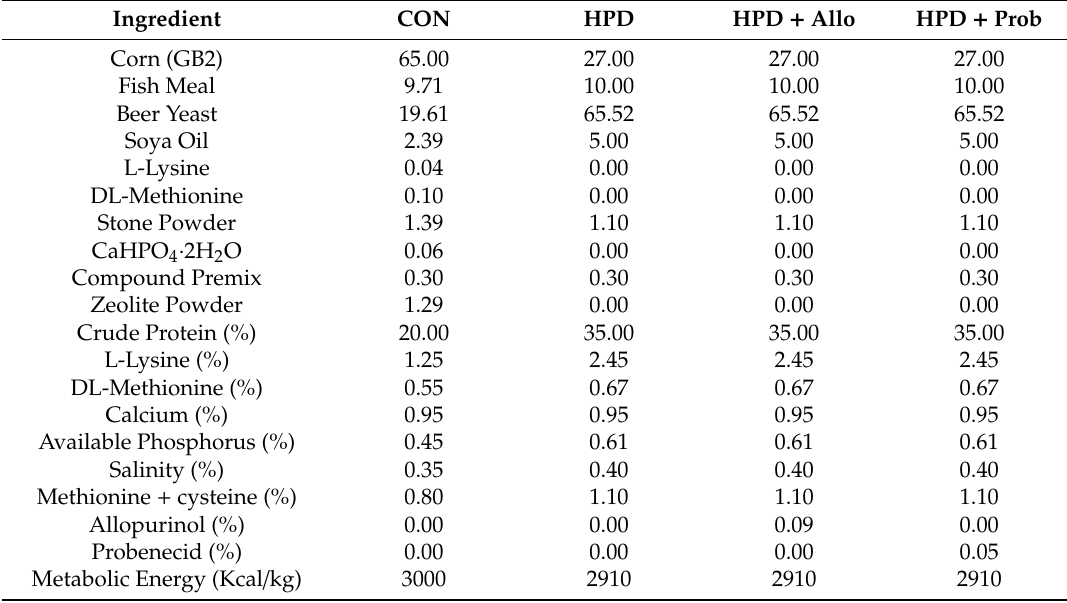
Table 4. Feed ingredients of second